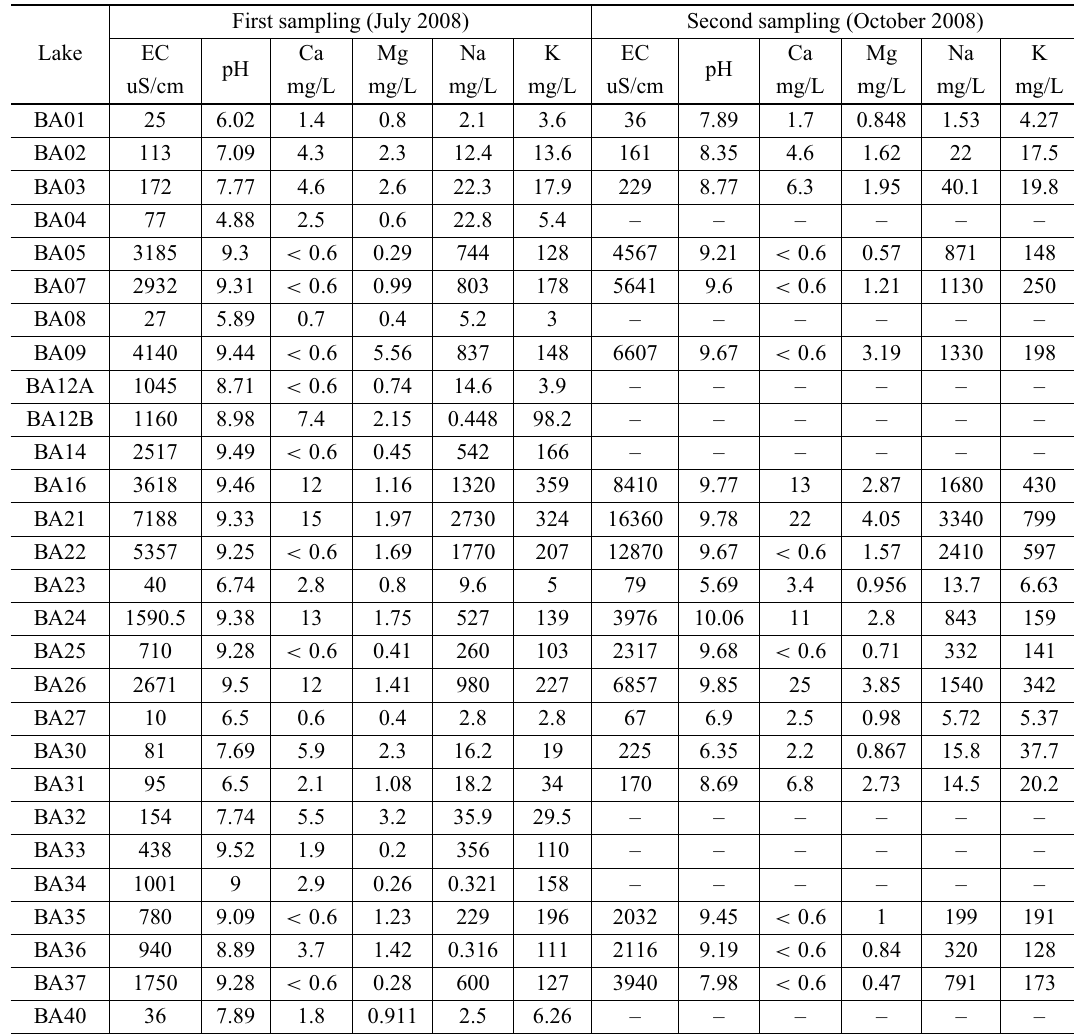
EC, pH and content in mg/L of Ca 2 + , Mg 2 + , Na + and K + of samples from the Barranco Alto farm